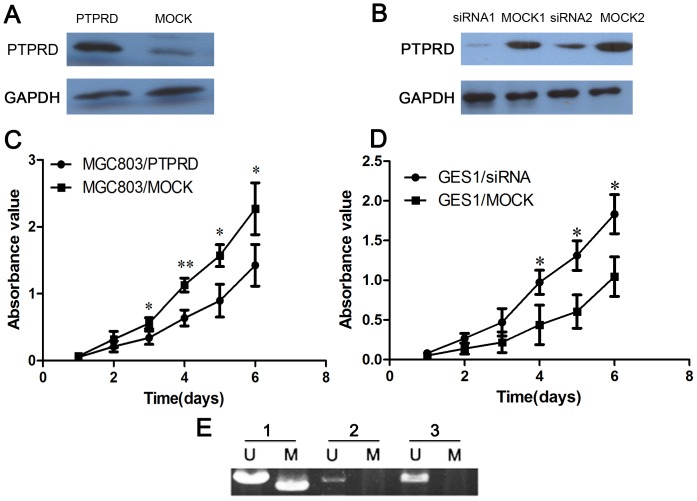
The growth suppressor role of PTPRD in cell proliferation and DNA methylation analysis of PTPRD.(A) Western blotting analysis of PTPRD overexpression in MGC803 cells. (B) Western blotting analysis of decreased PTPRD expression in GES1 cells. (C) Cell proliferation assay showing the suppressive effect of restoring PTPRD expression on the proliferation of MGC803 cell line. (D) Results showing significantly enhanced proliferation rate of PTPRD-silenced GES1 cells compared with mock siRNA treatment GES1 cells. (E) Methylation analysis of PTPRD promoter CpG island in primary GC tissues. Among 3 GC samples, one case showed partial methylation and 2 cases were unmethylated. *, P<0.05 versus the mock control; **, P<0.01 versus the mock control.